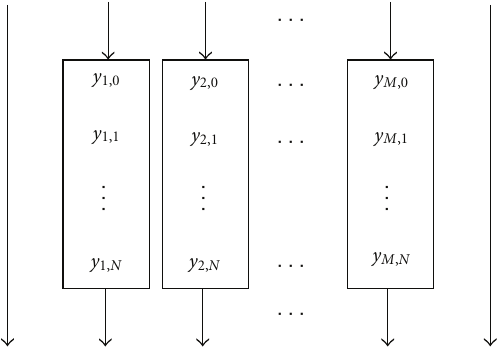
Figure 3: A 2D block of symbols out of an OFDM stream. We are interested in M adjacent sequences of N + 1 subsequent symbols, where each such sequence corresponds to one of M adjacent